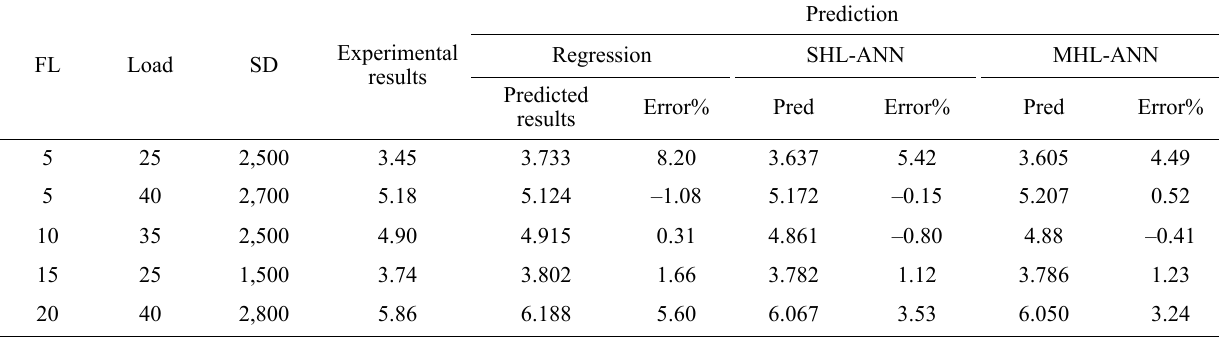
Table 21 Confirmatory tests for the amount of wear.